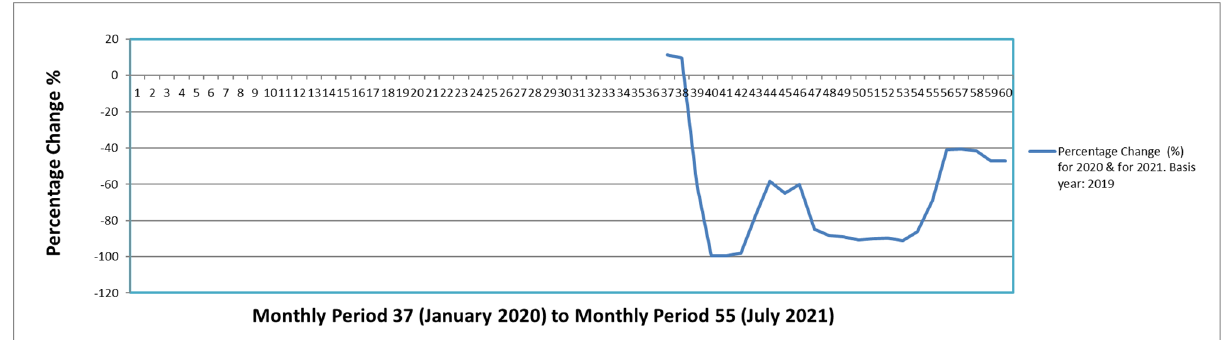
Figure 5. Rate of change for international pax air traffic in Greece.